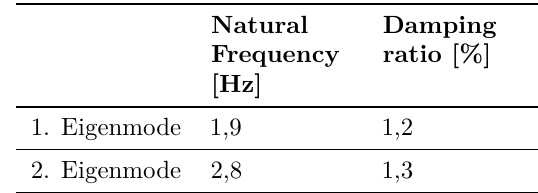
Table 3. Natural frequencies and damping ratios of the x-direction of the RC-building.